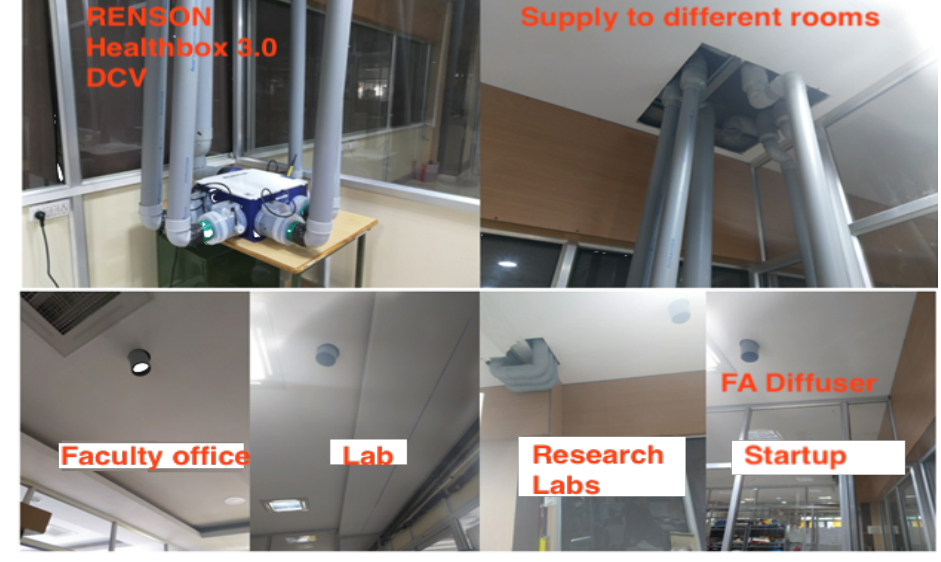
Figure 3. RENSON Healthbox 3.0 DCV